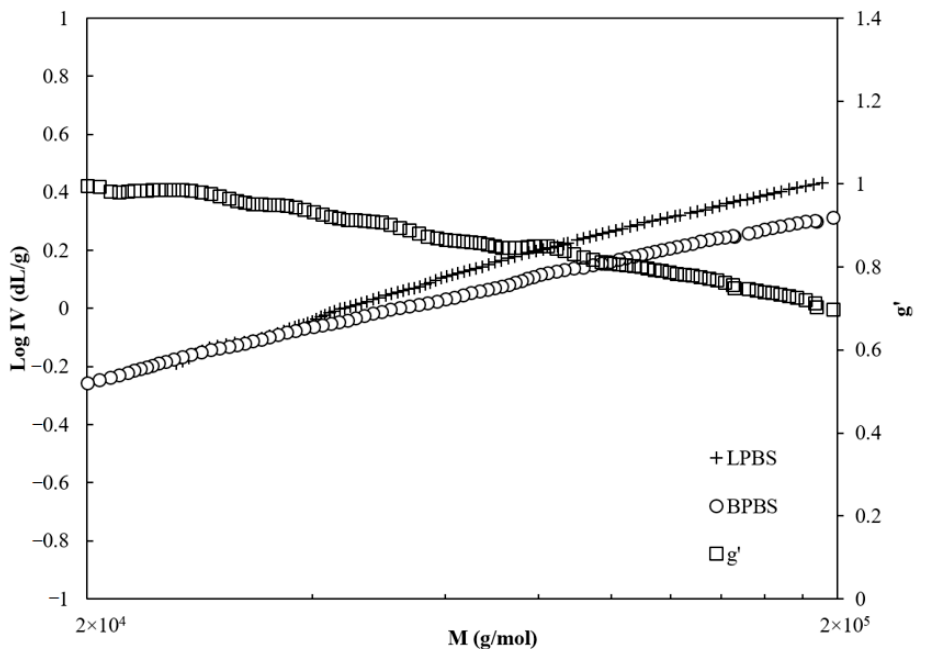
) and g (cid:48) the viscosity branching index ( ), (cid:51) (cid:35)